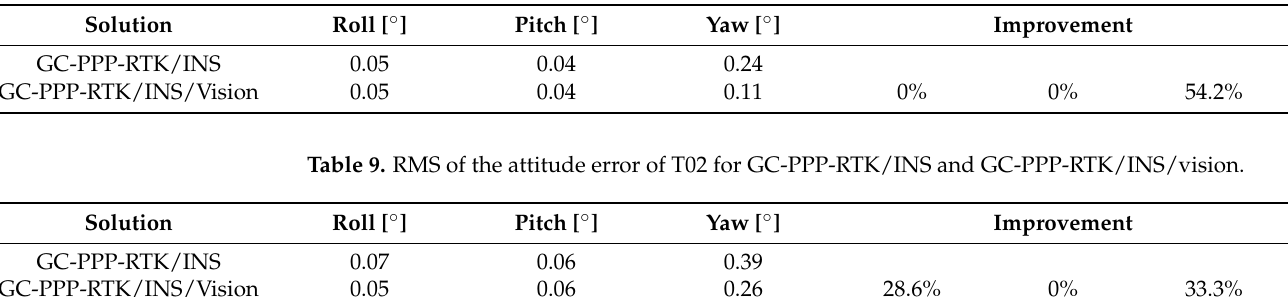
Table 8. RMS of the attitude error of T01 for GC-PPP-RTK/INS and GC-PPP-RTK/INS/vision.